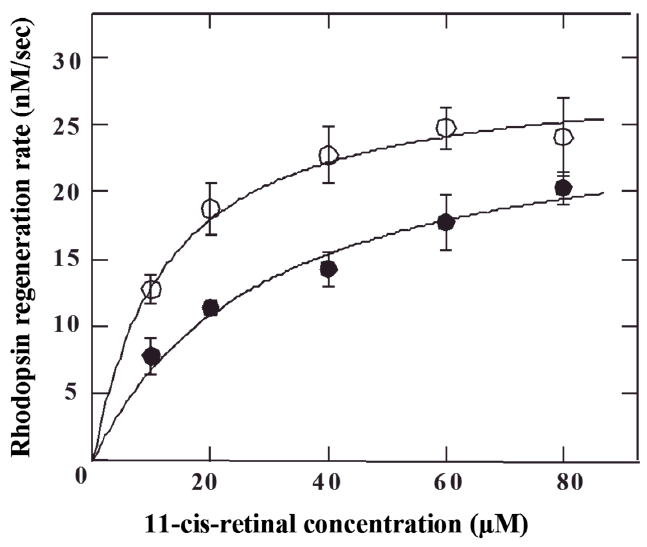
Figure 4. Effect of C3R on the initial rate of rhodopsin regeneration. Initial velocity of rhodopsin regeneration was determined for 40 s in the C3R ( ○ ) and control ( ● ) at each 11-cis-retinal concentration. The data points were fitted with eq 2 to calculate rate constants in the regeneration reaction ( n = 6, mean ± SE).